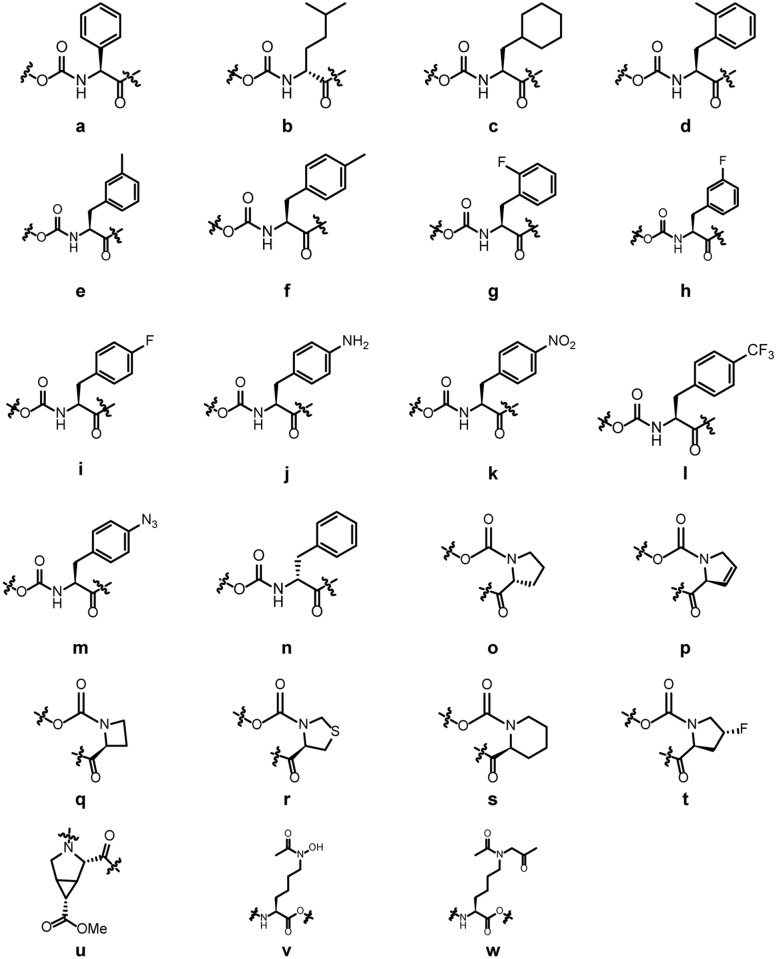
Analogs of amino acids used as surrogates to modify parental peptides.